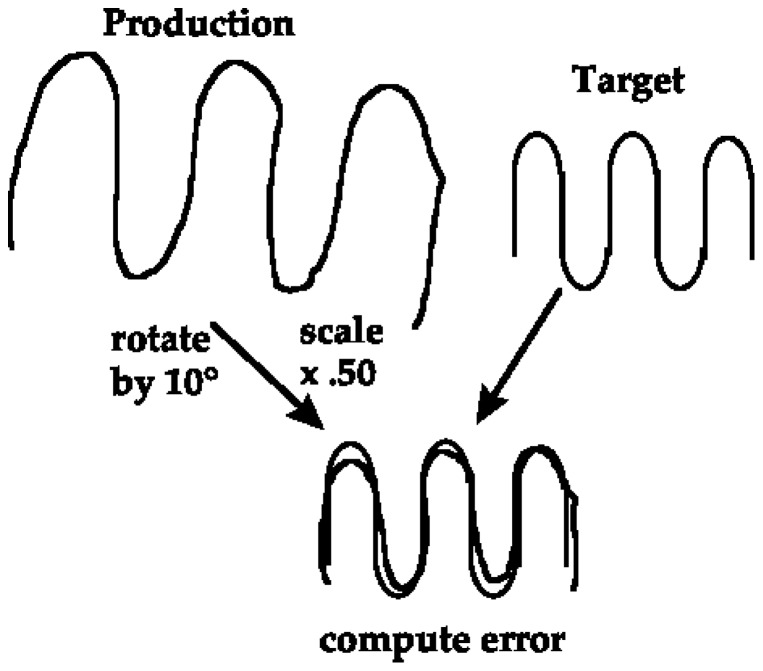
Illustration of the computer based method used to analyze drawn reproductions of the target forms.